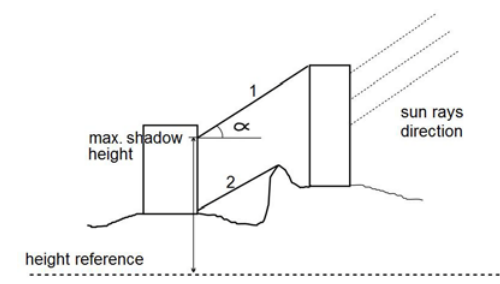
Figure 3. Assignment of shadow height to a XY façade cell: only shadow line 1 is relevant for this assignment.